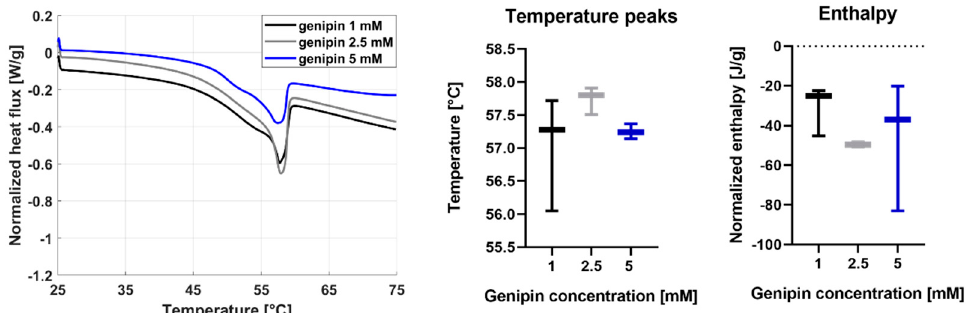
Figure 5. Results of the DSC analysis on the JellaGel™ hydrogels crosslinked with genipin at different concentrations. Heat flux vs. temperature curves are shown for one representative sample of each genipin concentration. The temperature peak and enthalpy are also reported for all sample types.